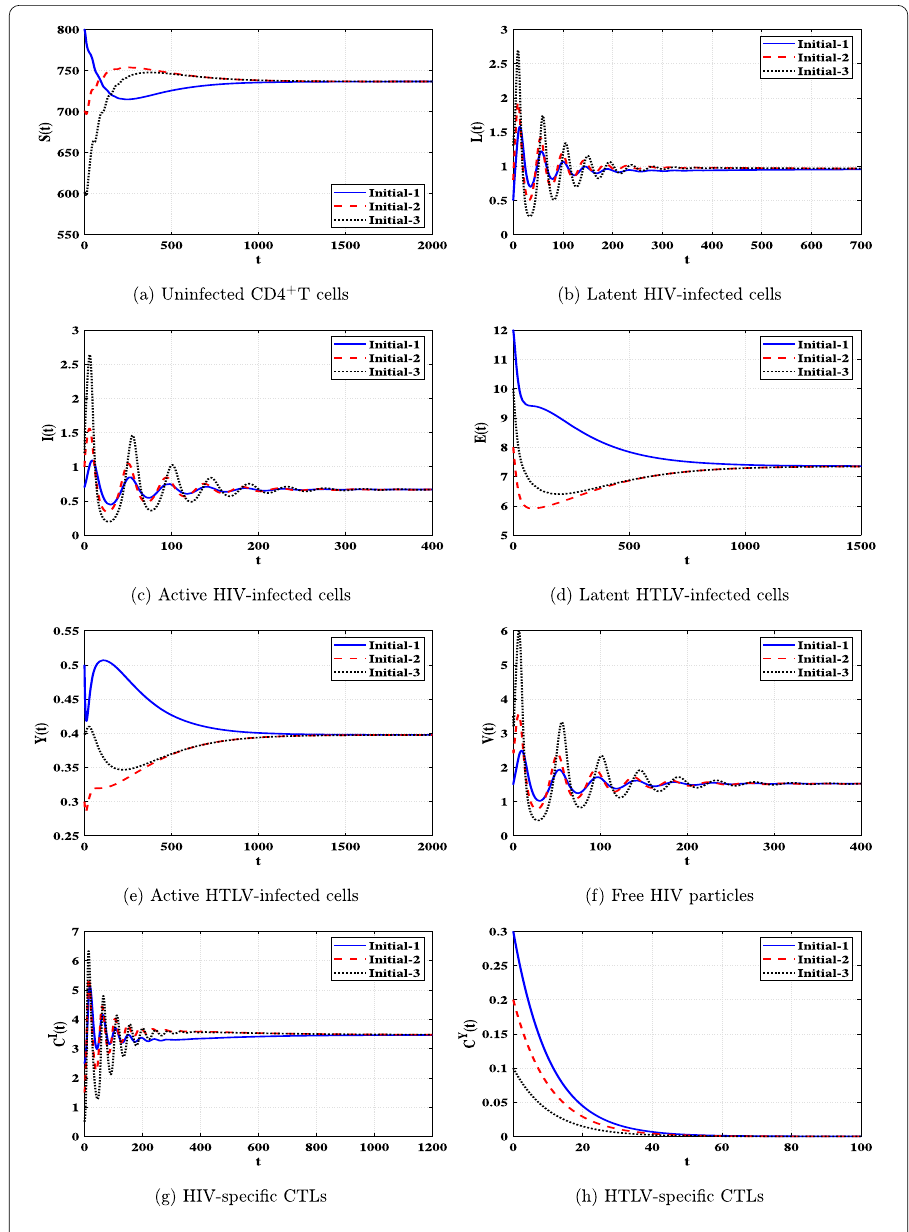
Figure 6 Solutions of system (29) when (cid:9) 5 > 1, (cid:9) 8 ≤ 1, and (cid:9) 1 / (cid:9) 2 > 1